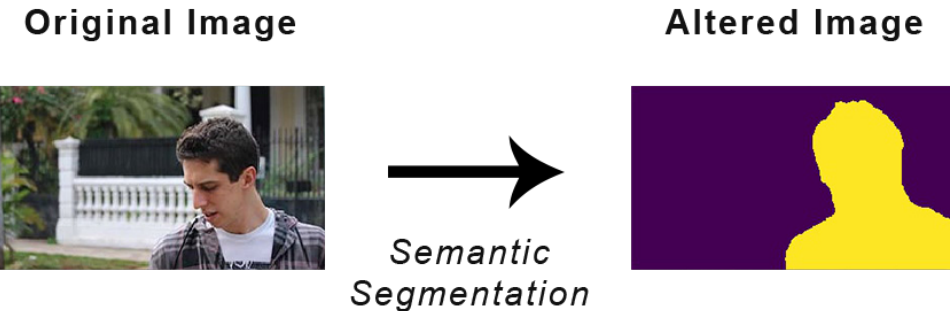
Figure 3. Example of an image alterated for the Hypercolumns